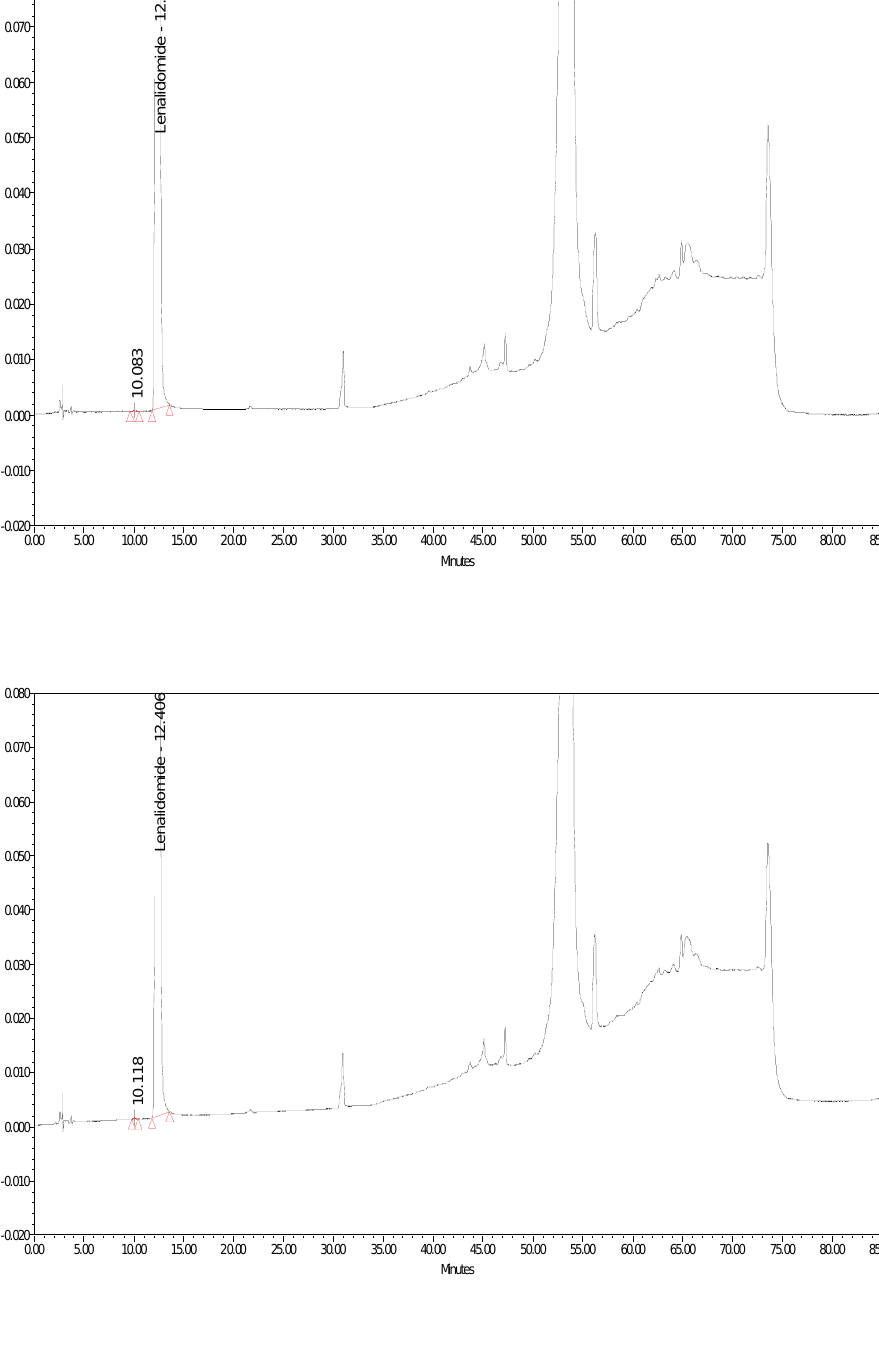
Figure 2 . Typical purity and HPLC chromatograms of lenalidomide capsules and various stressed